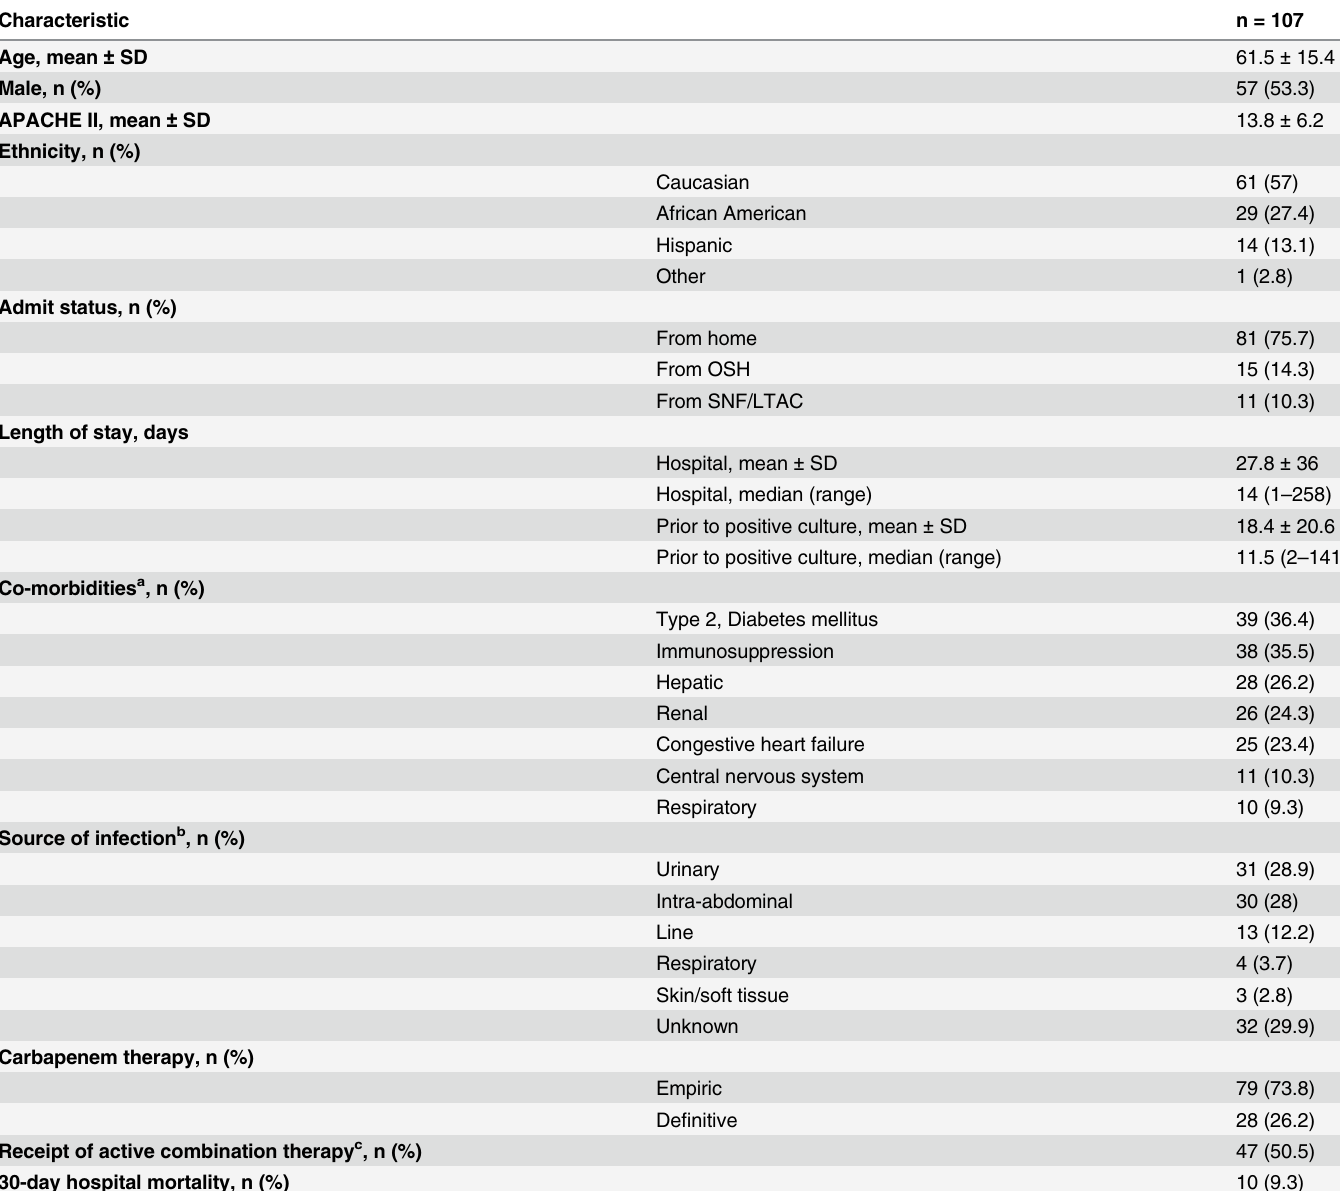
Table 1. Clinical characteristics of the study patients (n =